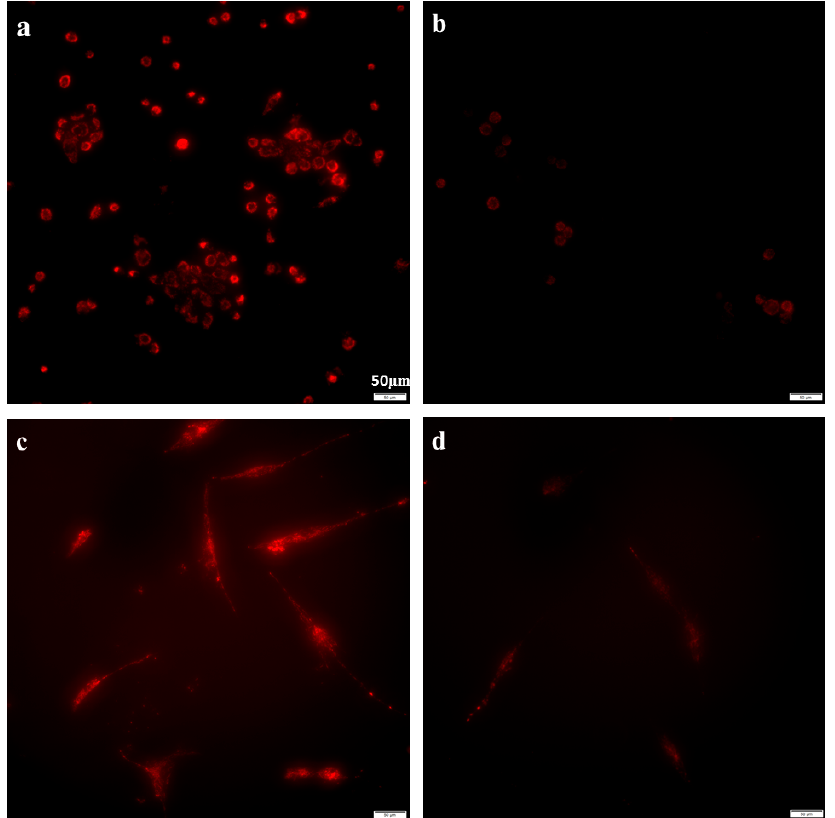
Figure 1. Azithromycin inhibited the proliferation of MCF-12A cells and fibroblasts in a dose- dependent pattern. Cells were incubated in the media containing azithromycin for 7 days.